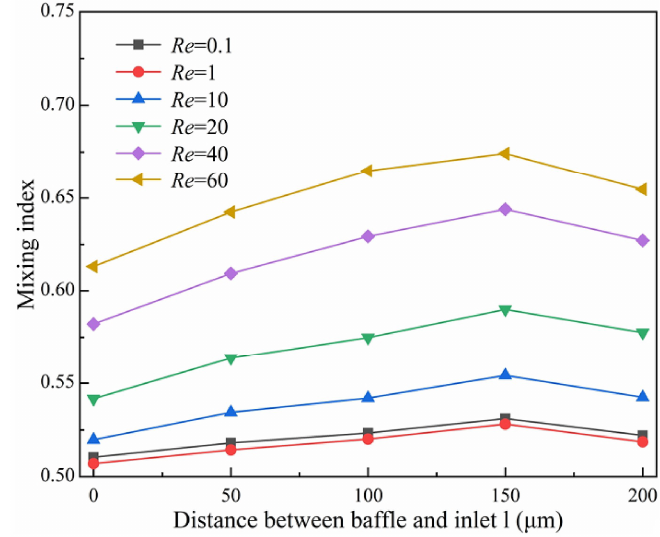
Figure 16. Effect of the distance between the baffle and inlet on mixing index.